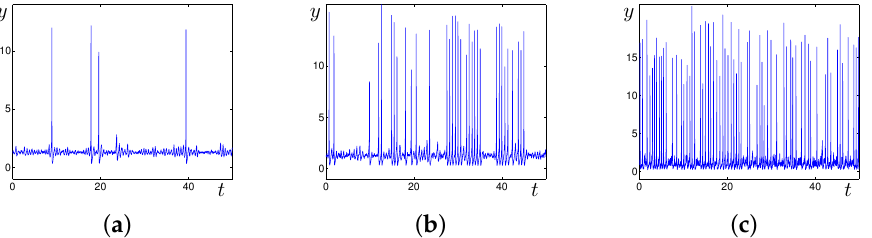
Figure 8. Noise-induced spiking oscillations in the system (2) with D = 0.248 for: ( a ) ε = 0.006, ( b ) ε = 0.01, ( c ) ε =